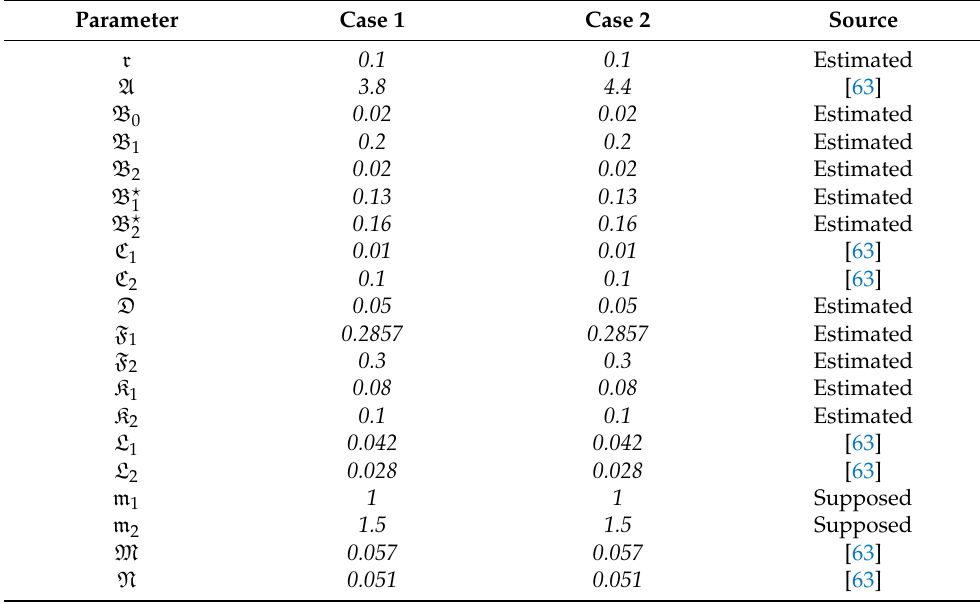
Table 3. Numerical values of the system parameters used in the simulations.